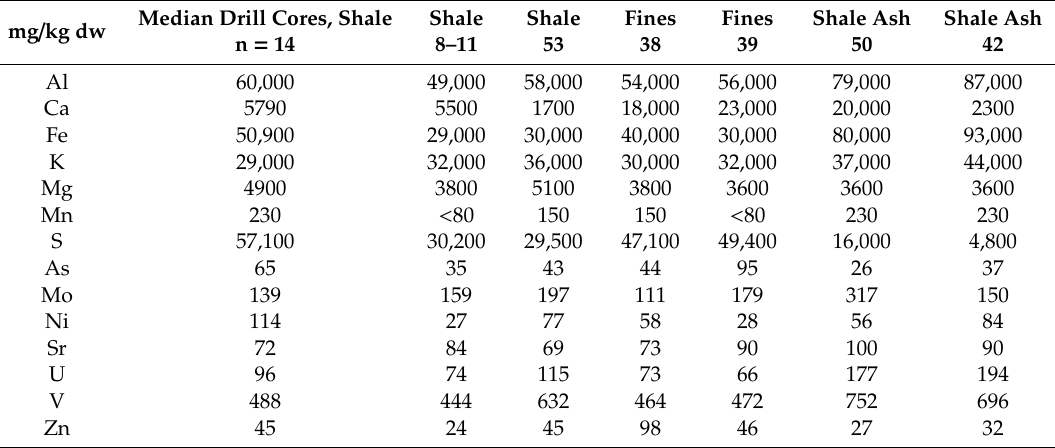
Table 2. Total concentrations (mg / kg dw) in solid